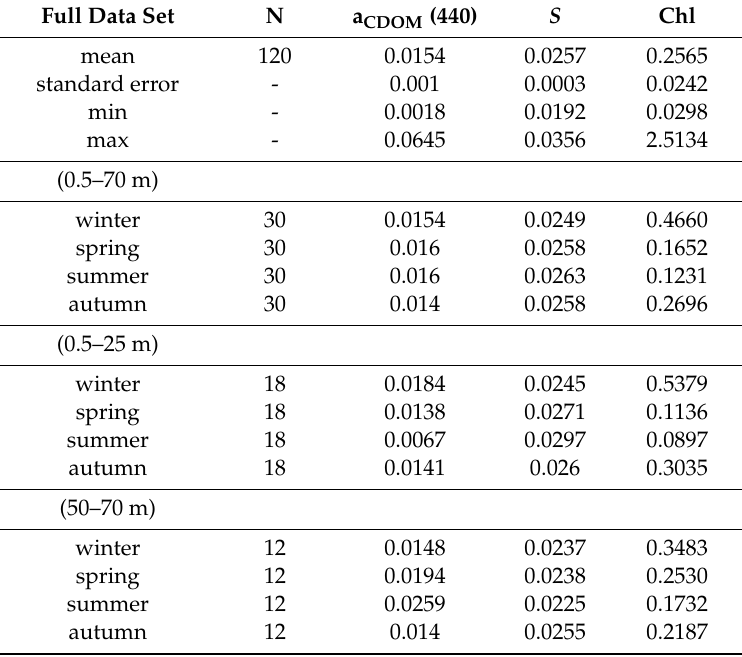
Table 1. Full data and seasonal mean values of a CDOM (440) (m − 1 ), S (nm − 1 ) and Chl (mg m − 3 ) in the entire water column (0.5–70 m), the surface layer (0–25 m) and the deep layer (50–70 m). N : number of